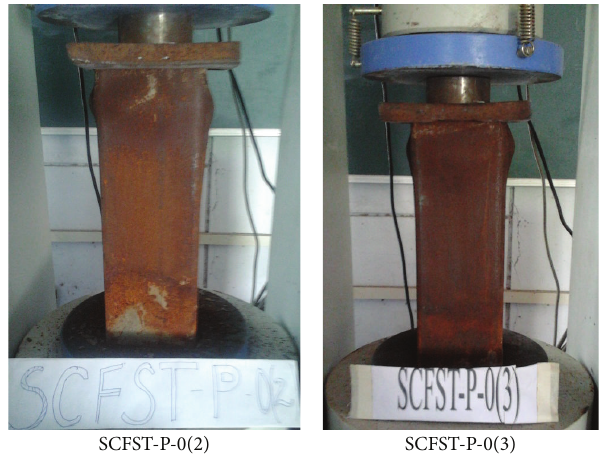
Figure 4: Failure pattern of square CFST column subjected to partial/local compression.